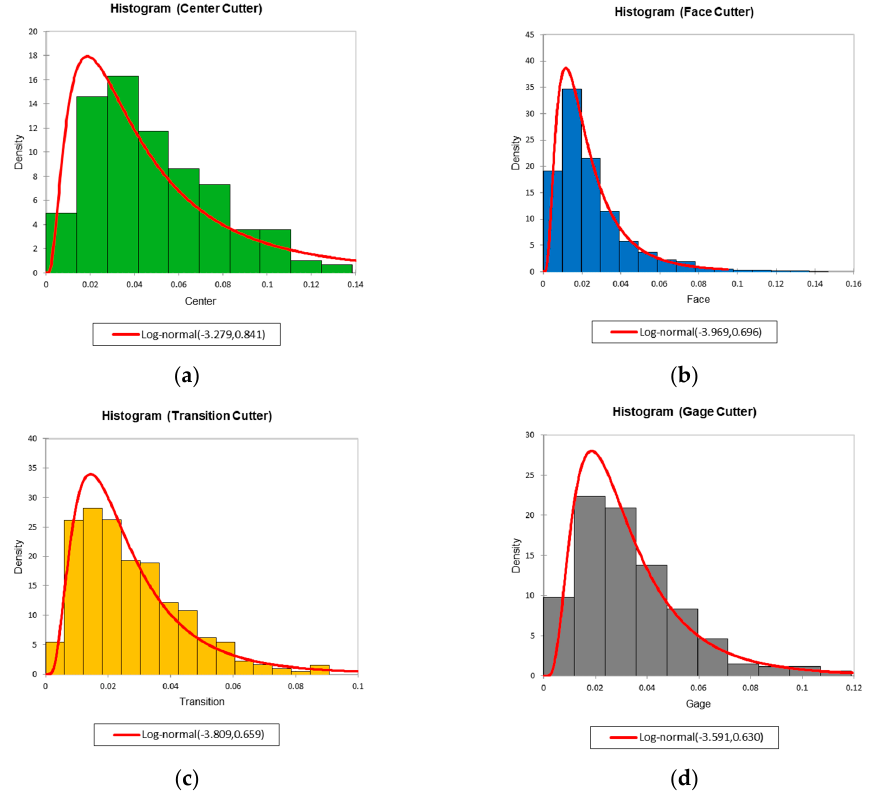
Figure 9. Histograms of the wear coefficient of disc cutters with respect to position: ( a ) centre cutters; ( b ) face cutters; ( c ) transition cutters; ( d ) gage cutters.